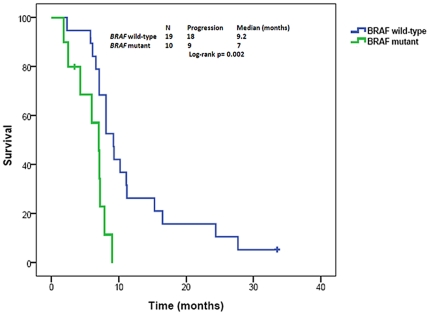
Kaplan Meier curve showing progression-free survival on best standard systemic treatment comparing patients with mutBRAF vs. wtBRAF metastatic colorectal cancer.(One patient with inadequate records on prior treatment was excluded).